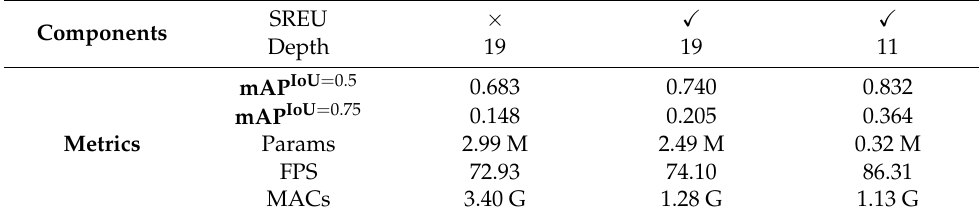
Table 5. Ablation study of Autofocus